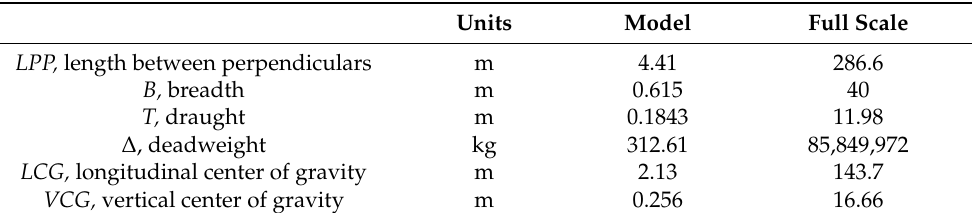
Table 1. Main dimensions of a 6750 TEU containership scale model. Units Model